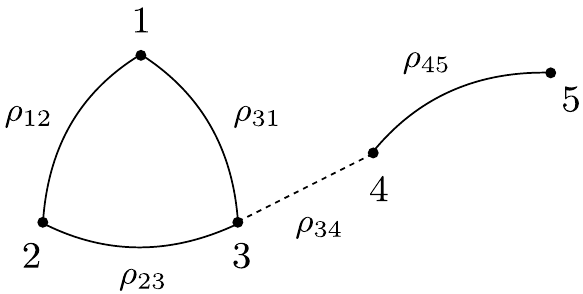
Figure 12 . The structure of a solution to the saddle-point equation for the (cid:12)ve-point function, which corresponds to a disconnected diagram. The black solid lines denote (cid:26) (cid:12)elds which are nonzero while the dashed line and the lines which are not drawn correspond to (cid:26) (cid:12)elds which vanish. The one shown in (cid:12)gure corresponds to a product of a three-point function and a two-point function.